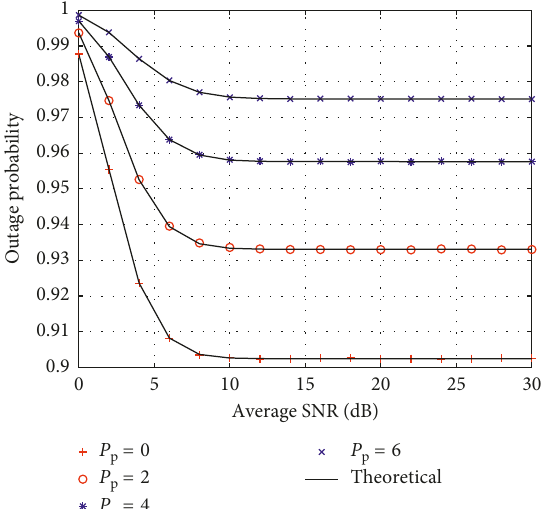
Figure 3: Outage probability for different PS’s transmission powers.